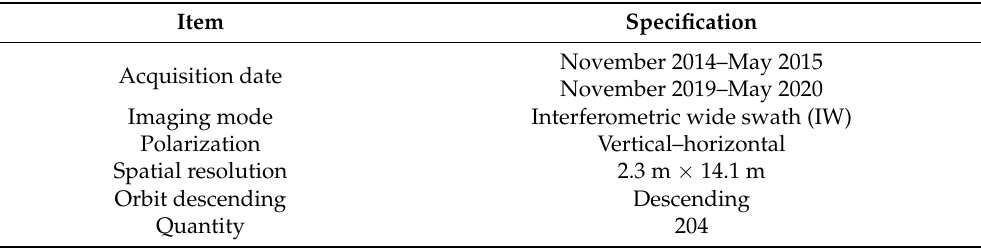
Table 1. Major characteristics of Sentinel-1 data used in our study.